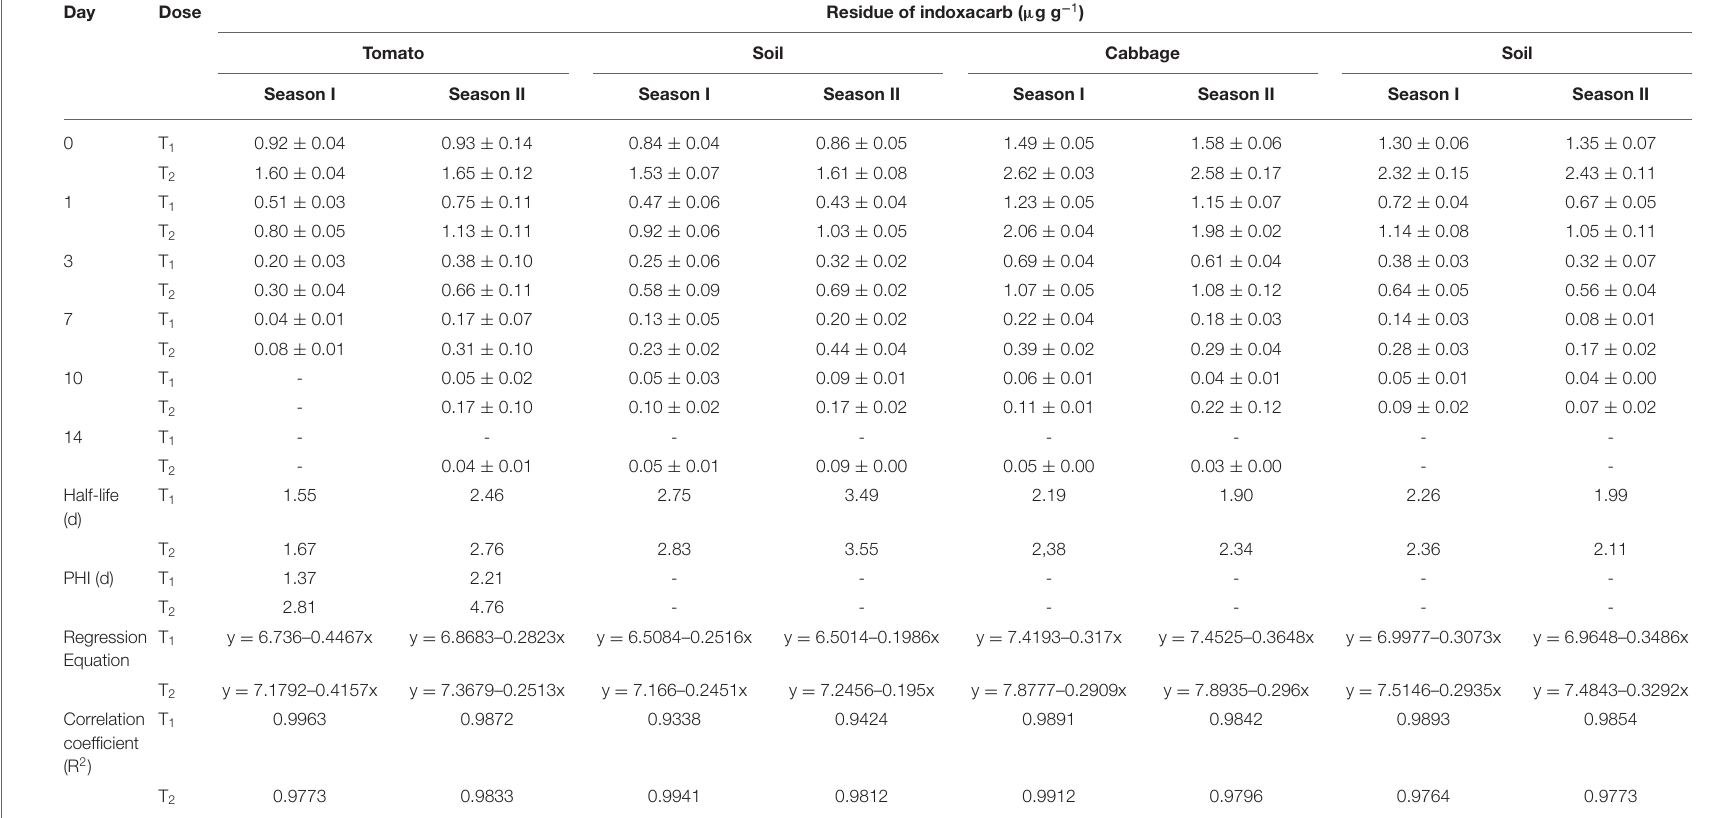
ND, Not Detected at LOQ of 0.03 µ g g − 1